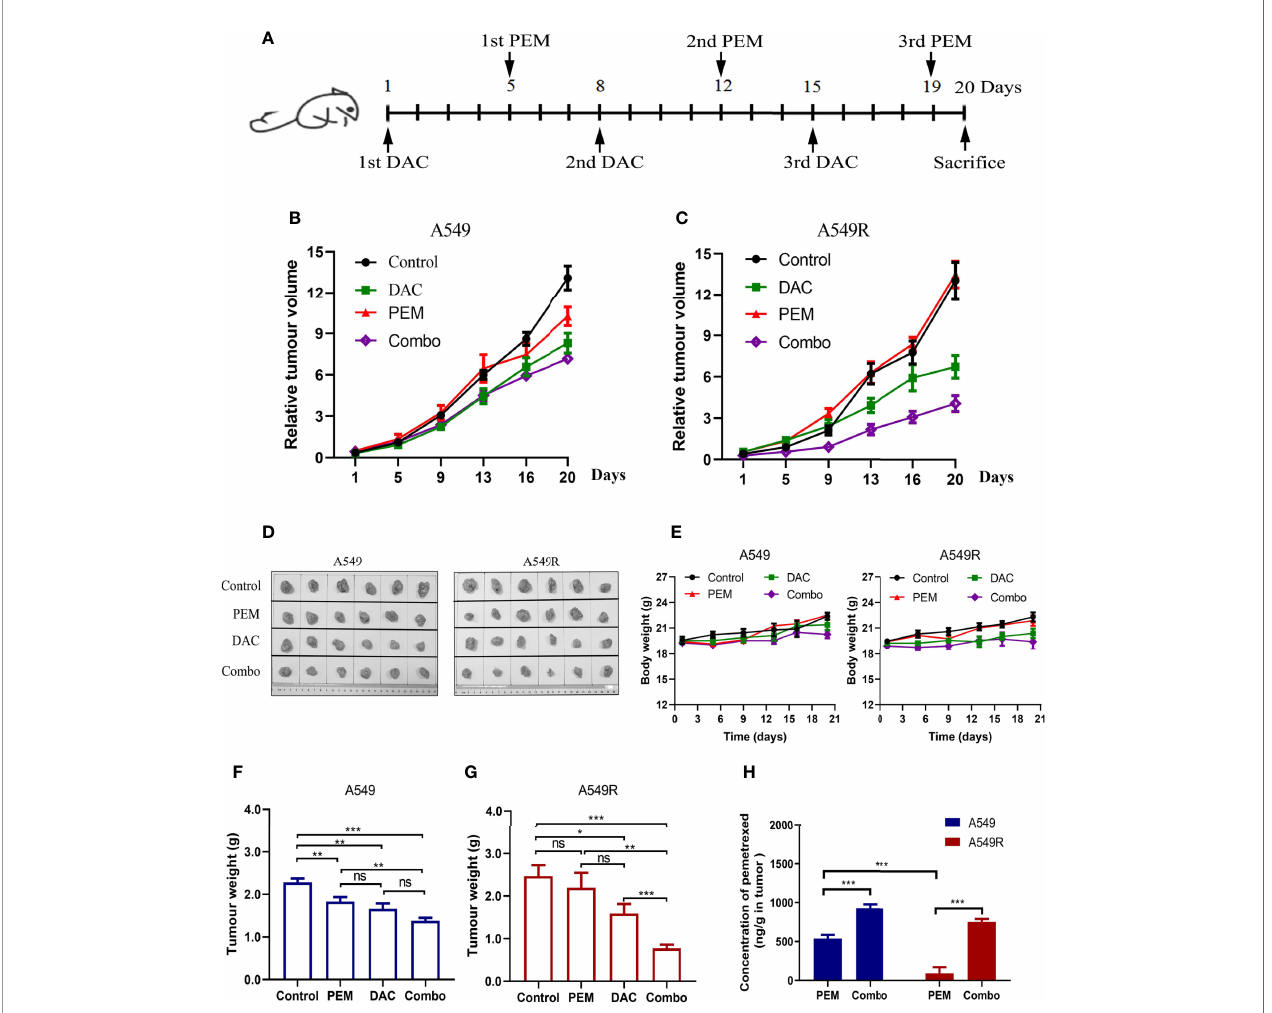
FIGURE 7 | Decitabine sensitizes A549 and A549R cells to pemetrexed in xenograft models. (A) Experimental timeline and dosing schedule for xenograft models. (B, C) Tumor growth curves for A549 and A549R xenografts. (D) Tumors after resection from mice on day 20. (E) Body weight curves for A549 and A549R xenografts. (F, G) Tumor weight of A549 and A549R xenografts on day 20. (H) The concentration of pemetrexed in tumors of A549 and A549R xenografts. Data are presented as the means ± SE from 6 mice. Groups with different letters show signi fi cant differences using ANOVA followed by Tukey ’ s test. Differences between the two groups are denoted as *p < 0.05, **p < 0.01 and ***p < 0.001. ns, not signi fi cant. Control, DAC, PEM, and Combo indicate mice treated with saline, decitabine alone, pemetrexed alone, and decitabine-pemetrexed combination,